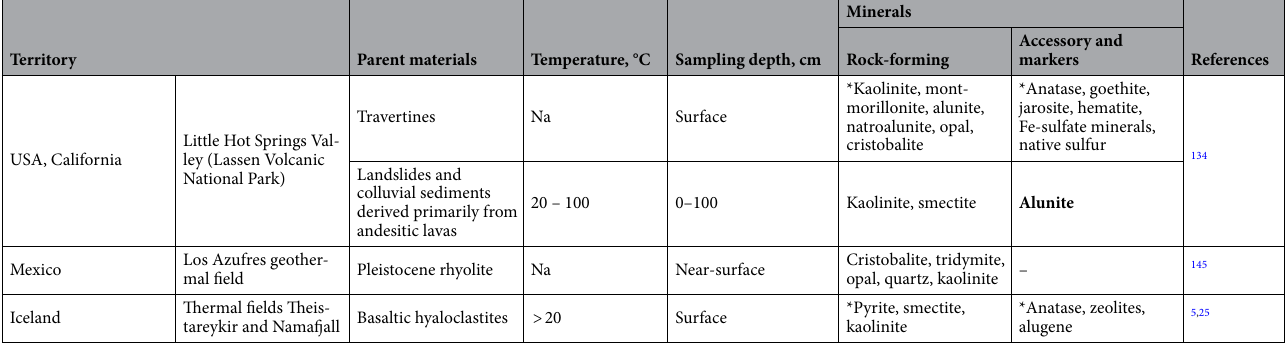
Table 2. Mineral associations in soils and parent materials within zones of discharge of steam-heated acid- sulfate waters. *PM